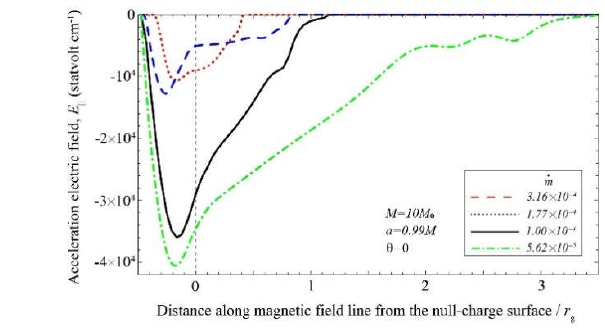
( b ) Figure 11. ( a ) Luminosity of BH lepton accelerators when a 10-solar-mass, extremely rotating ( a = 0.99 M ) BH is moving with velocity V in a cloud whose molecule hydrogen density is 2 H n . The five straight lines correspond to the Bondi-Hoyle accretion rates, 10 −2 , 10 −3 , 10 −4 , 10 −5 , and 10 −6 , as labeled. In the lower-right white region, the gap vanishes due to efficient pair production. In the upper-left white region, stationary accelerators cannot be formed. Thus, stationary accelerators arise only in the